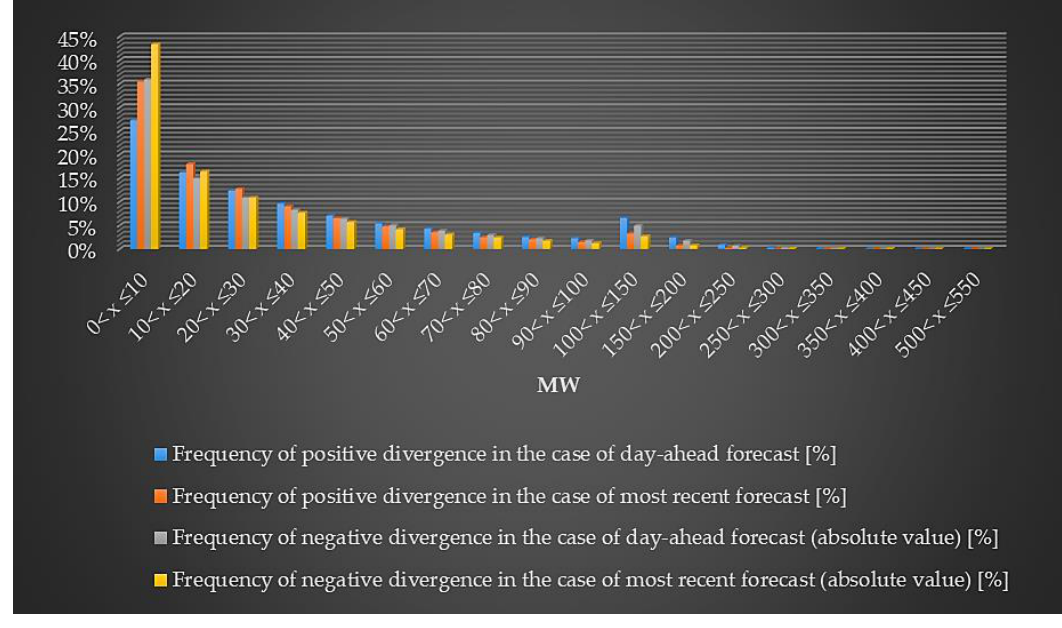
Figure 5. The magnitude of the day-ahead PV power forecast divergence (15 min-based) compared to the real PV power data for the period of 30/09/2014–30/09/2019.